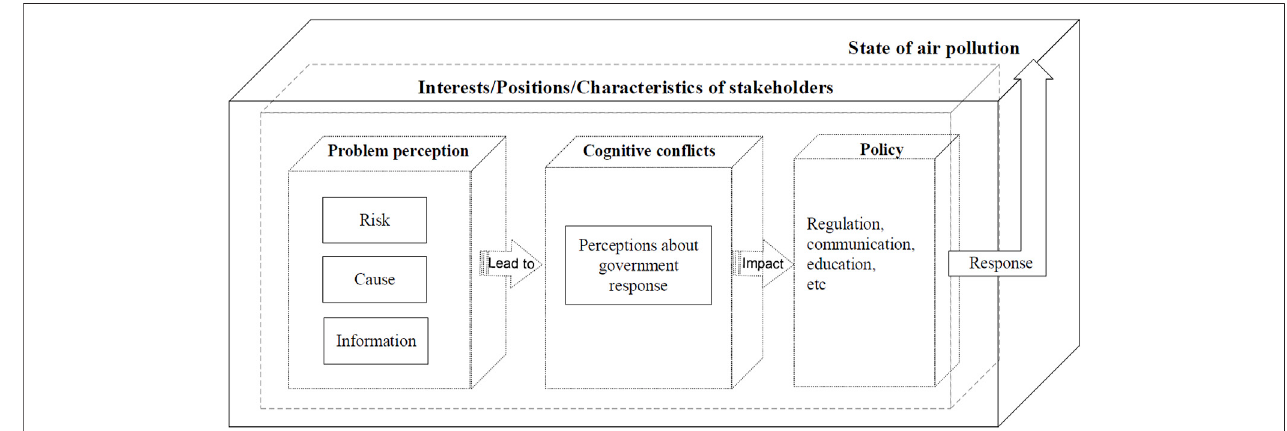
FIGURE 1 | A logic model approach to air pollution perception